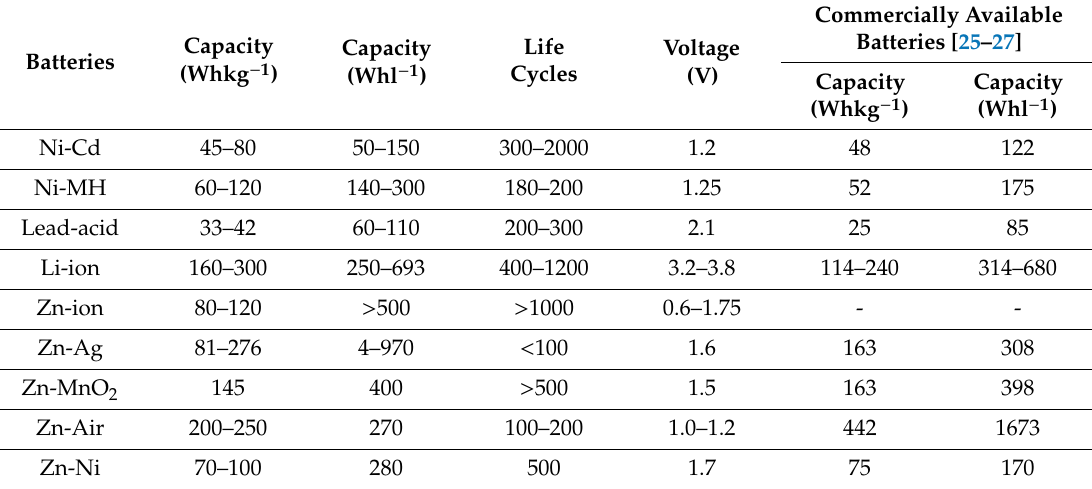
Table 1. Comparison of di ff erent batteries. Data from references